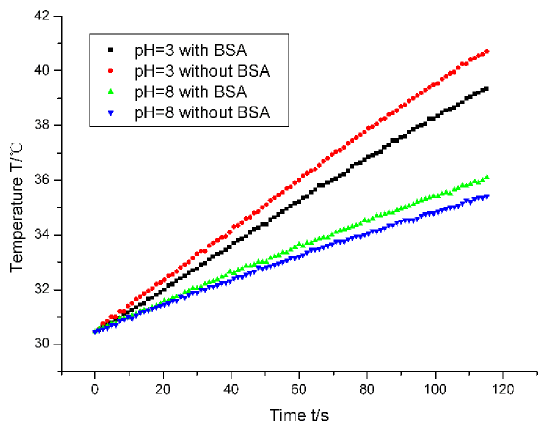
Figure 5. The heating curve of γ -Fe under acidic and basic conditions. The excitation current of the magnetic field generator was 200